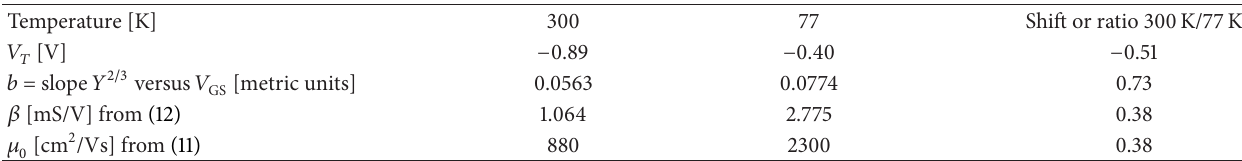
function, the subsequent 𝛽 parameter, GS = 3 V (saturation domain). DS